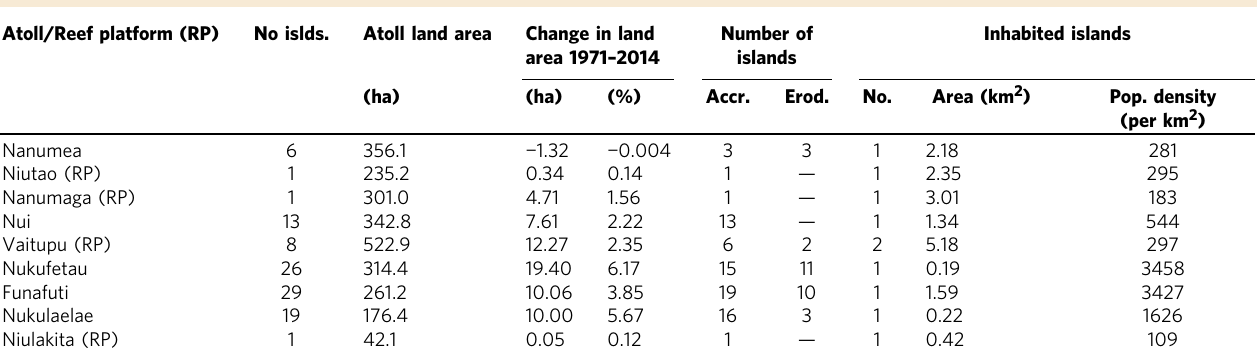
Island population data obtained from the Tuvalu Census of Population and Housing 28 Accr. accreted islands, Erod. eroded